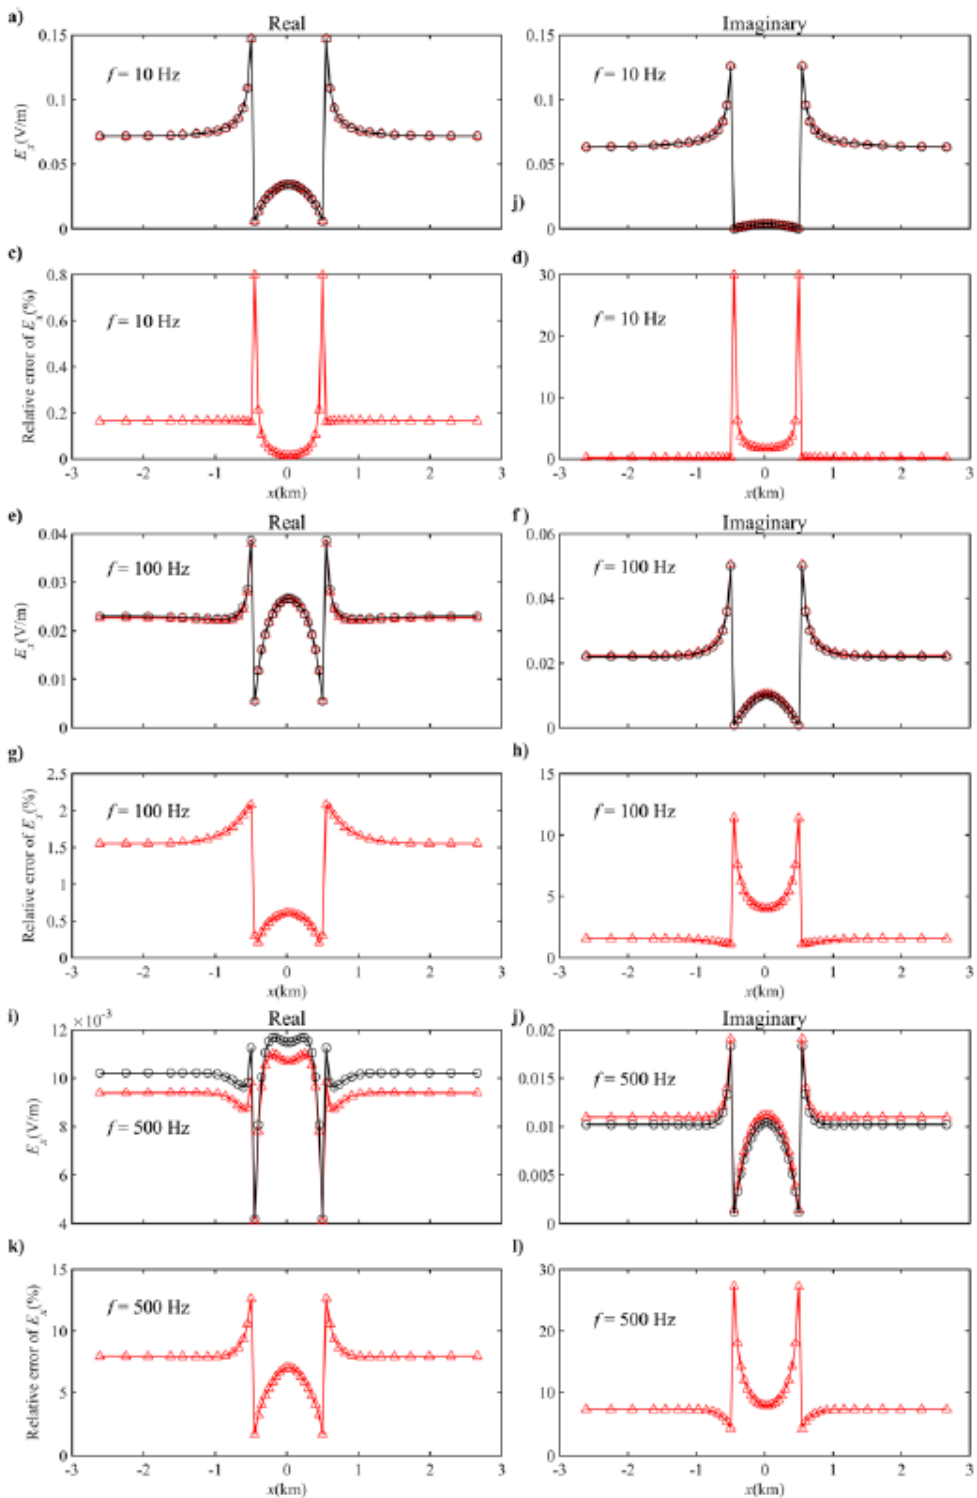
Figure 10. Comparison of the E x numerical solutions from the case based on the quasi-static approximation (upward-pointing triangle lines) with 10 − 6 S / m for air conductivity, and the one with the complete wavenumber (circle lines) at frequencies of ( a – d ) 10 1 , ( e – h ) 10 2 , and ( i – l ) 5 × 10 2 Hz for the steep hill model. The relative errors are referenced to the results based on the use of the complete wavenumber.